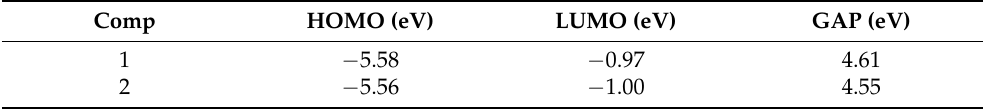
Table 1. HOMO, LUMO and GAP values obtained through quantum calculations.